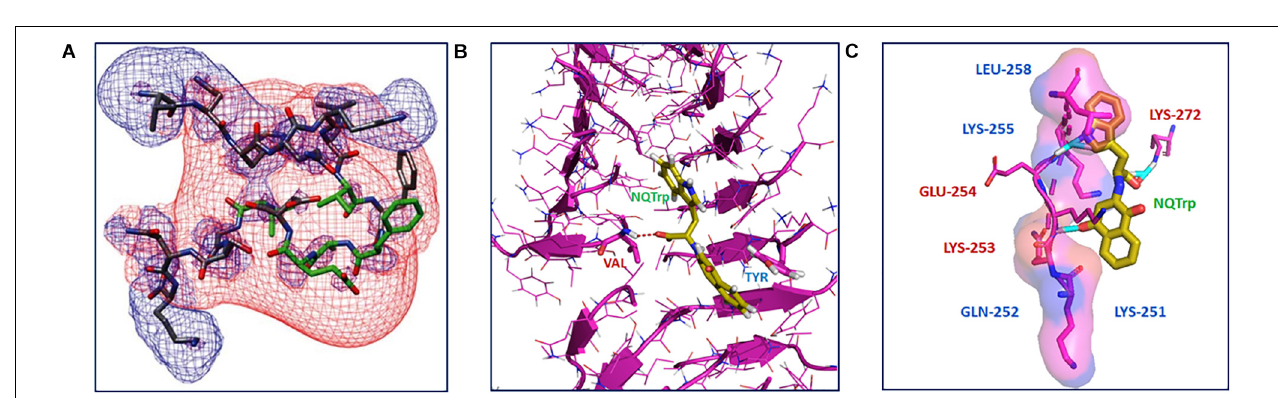
FIGURE 2 | Interaction of NQTrp with amyloidogenic peptides: (A) NMR spectroscopy analysis of A β peptide with NQTrp. Lowest energy structure generated for A β 12 - 28 with NQTrp (Molar ratio 4:1), where the residues colored in green showed significant deviations upon binding NQTrp. The negative (red) and positive (blue) electrostatic potential distribution for ± 2 kT/e are mapped onto the structure (Image reproduced from Scherzer-Attali et al., 2010). (B) Complexation of NQTrp with Tau-derived PHF6 peptides in the fibrillar arrangement during disassembly, observed during molecular dynamics simulation (Image reproduced from KrishnaKumar et al., 2018b). (C) Putative interaction sites of PAPf39 peptide with NQTrp leading to the inhibiton of its agregation, visualized using molecular docking (Image reproduced from Viswanathan et al., 2018). Interacting residues are shown as